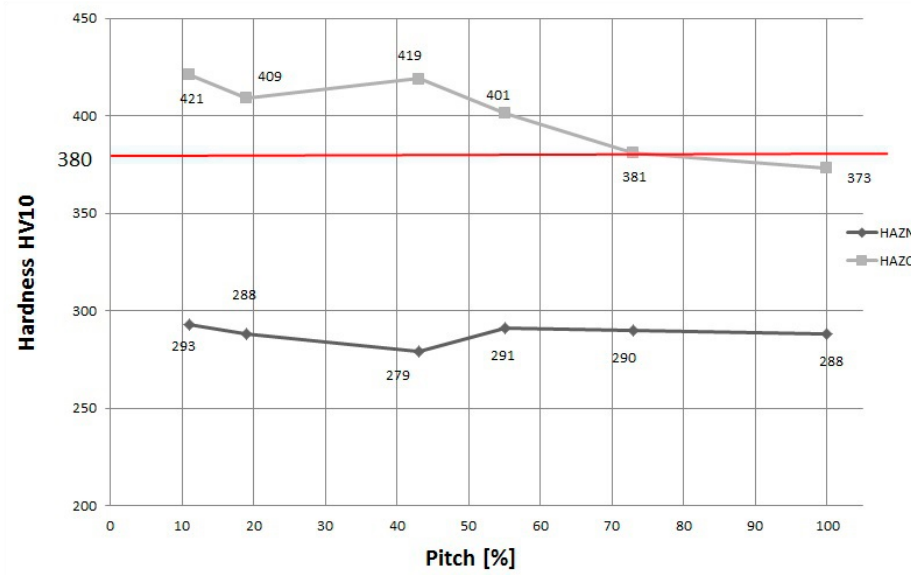
Figure 7. Hardness distribution for specimens with different overlap values in HAZO and HAZN areas of the first (tempered) weld.